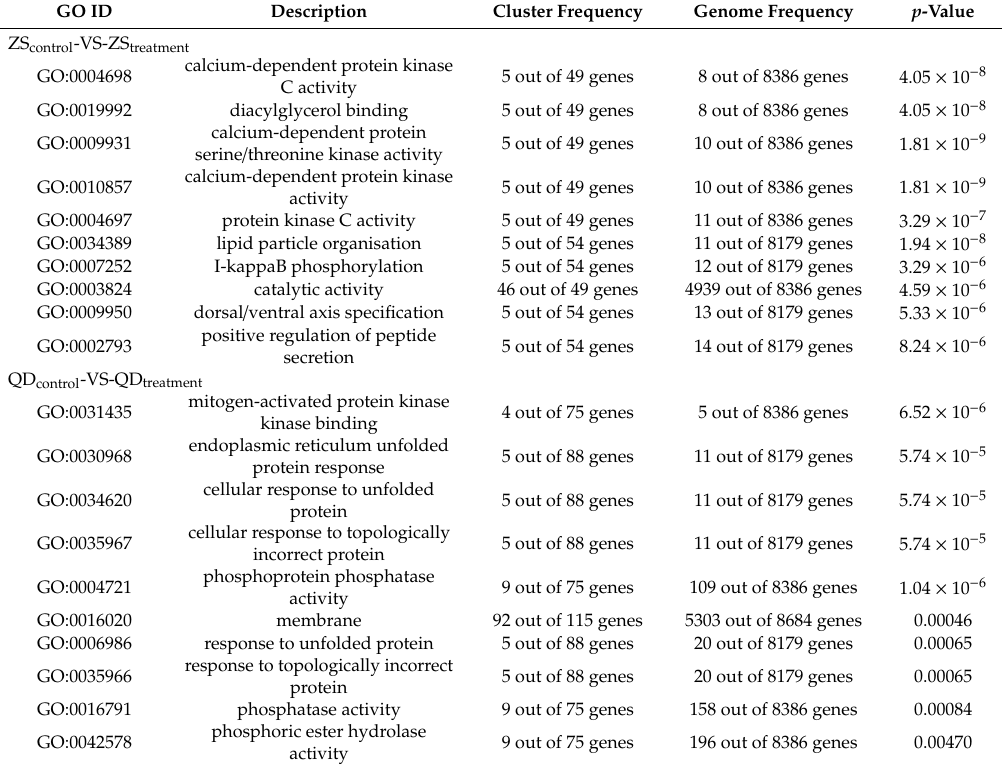
Table 4. Top 10 results of the enrichment analysis of GO terms of di ff erentially expressed unigenes of each population exposed to thermostress (ZS control : Zhoushan population at 20 ◦ C; ZS treatment : Zhoushanpopulationat28 ◦ C;QD control : Qingdaopopulationat20 ◦ C;QD treatment : Qingdaopopulation at 28 ◦